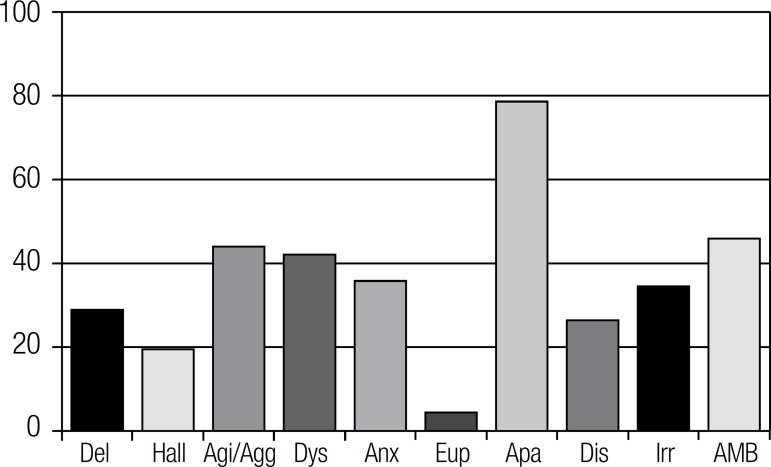
Prevalence of neuropsychiatric symptoms (%) (N=159).